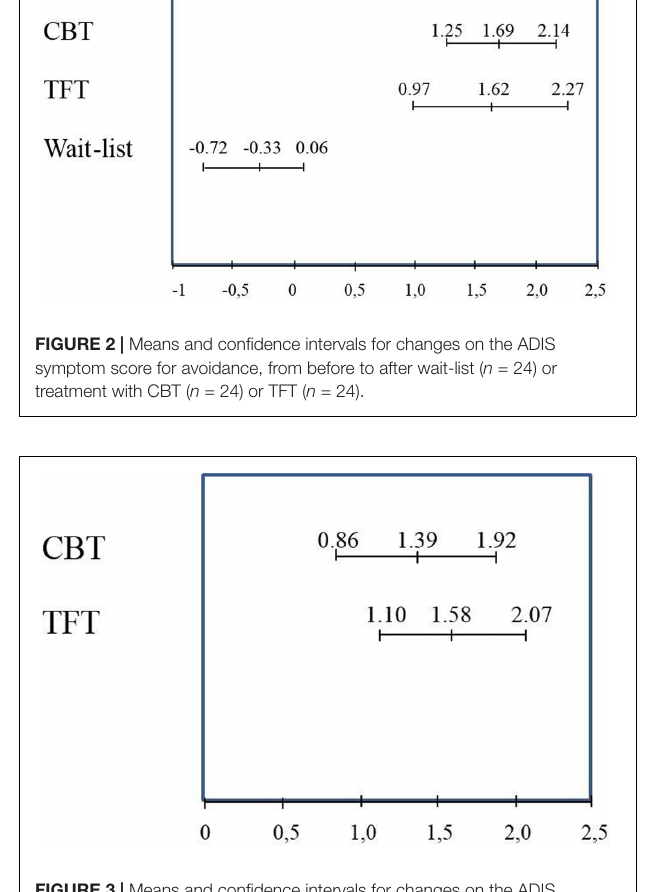
FIGURE 3 | Means and confidence intervals for changes on the ADIS symptom score for avoidance, from before to 12 months after treatment with CBT ( n = 36) or TFT ( n = 36).